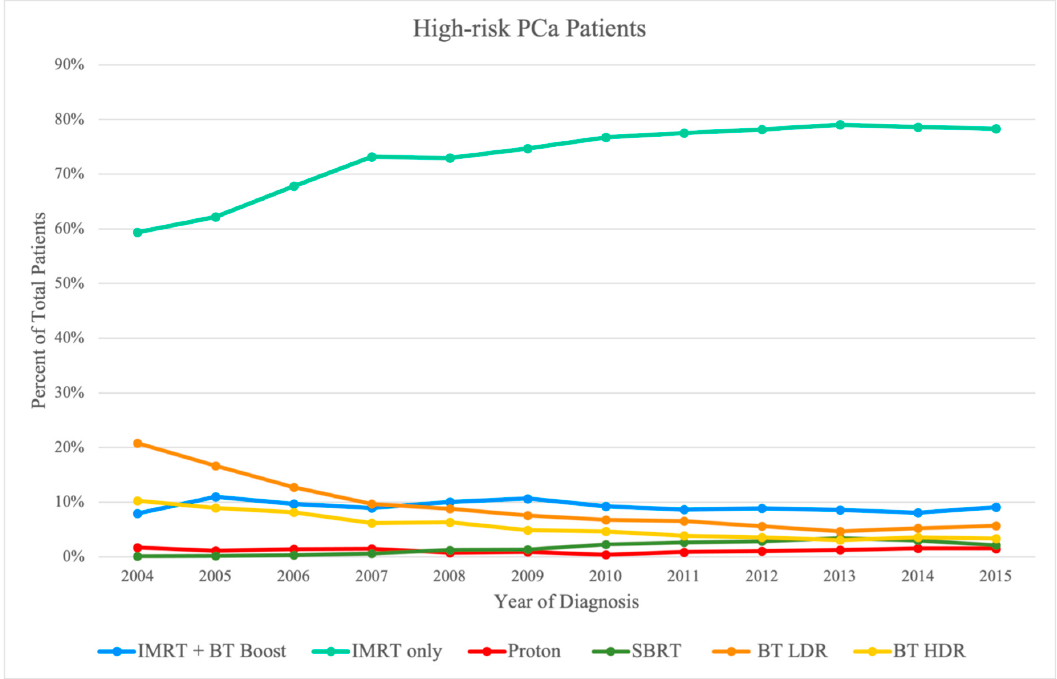
Figure 4. Pattern of utilization of radiation therapy modality for high-risk PCa patients by treatment modality.